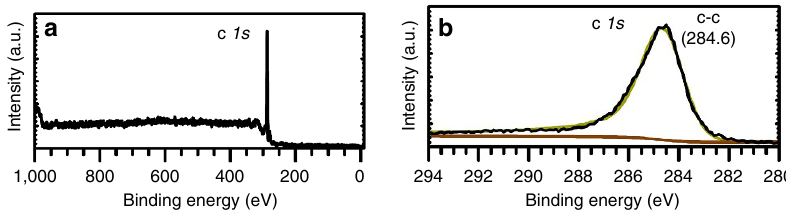
Figure 2 | XPS analysis of the graphene on diamond sample. ( a ) The full survey XPS scan of the sample demonstrates the presence of prominent carbon C 1s peak on the surface, indicating absence of residual nickel on the surface as well as no oxygen presence. ( b ) detailed carbon C 1s peak confirms sp 2 hybridization of graphene through presence of C–C bond peak highlighted in green. Black colour indicates the collected XPS data and brown highlights the background mainly involving the fast, precise control of temperature ramping. doped free-standing single-layer graphene 26–28 , which we attribute The quality of the graphene films grown on UNCD was also to the high quality of the produced graphene. evaluated by measuring the sheet resistance using the We have also fabricated graphene top-gate field-effect four-point probe method. The sheet resistance of the obtained transistors. The current–voltage ( I–V ) characteristics of the graphene/UNCD films varied from 0.09 O per square for thick top-gated devices were measured using a semiconductor (20–30nm) graphene samples grown at 1,000 (cid:2) C to 3.1 O per parameter analyzer (Fig. 4). The linearity of the source-drain square for single-layer graphene grown at 800 (cid:2) C. This is the lowest current versus source-drain voltage ( I ds versus V ds ) curve (Fig. 4a) confirms the high-quality Ohmic contact. The V-shape of value of sheet resistance reported so far for multilayer, bilayer and